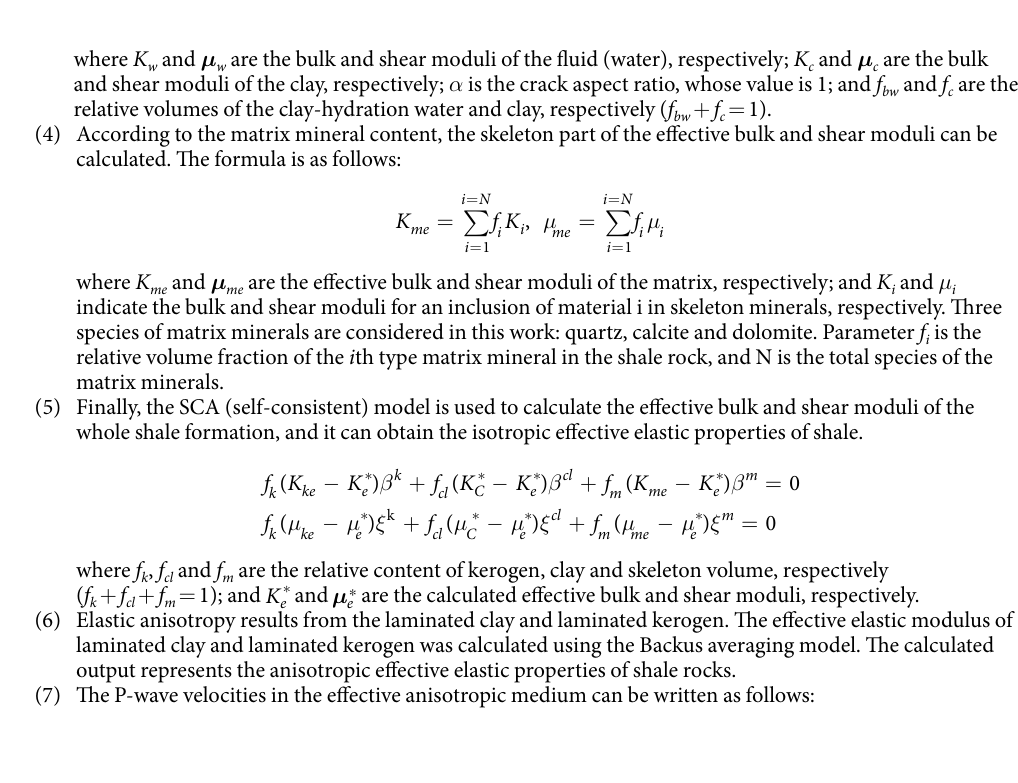
Figure 4. Modelling results of the real well logging data shown in Fig.